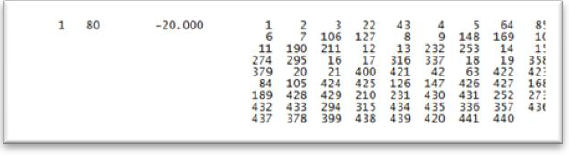
Figure 9. Procedure output with a single horizontal cluster per level